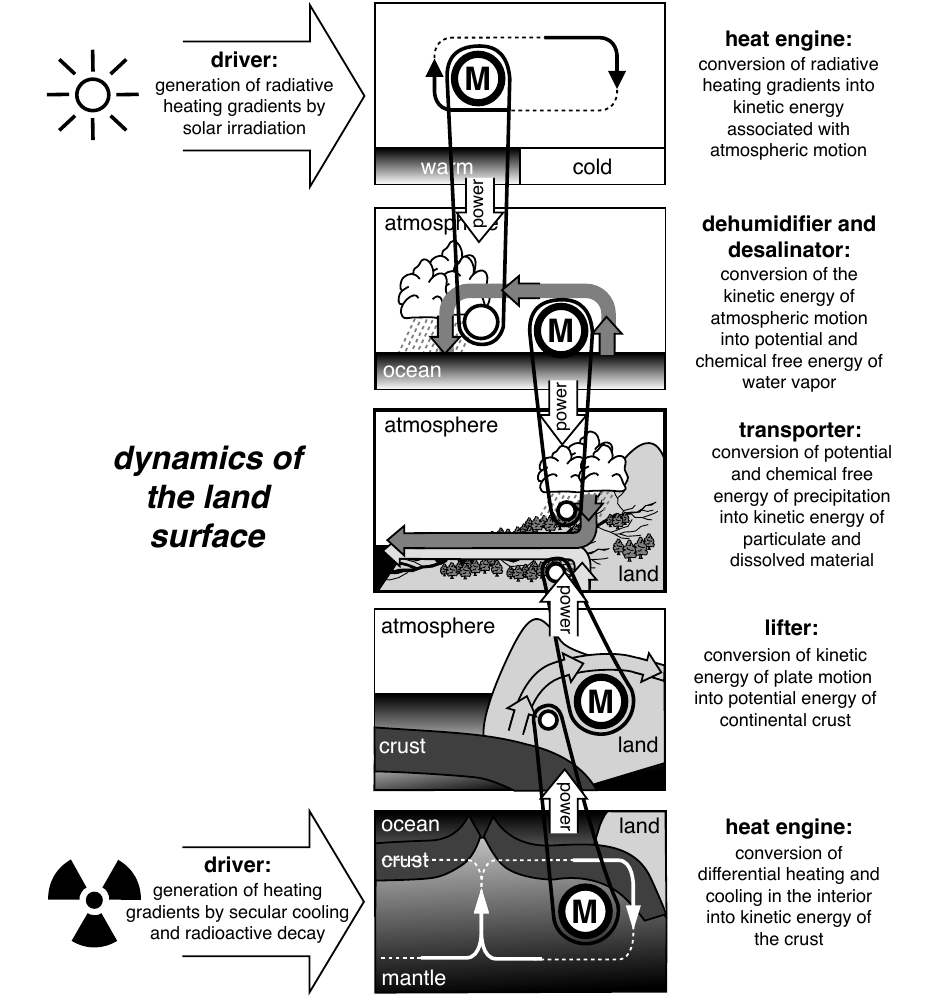
Fig. 2. Schematic diagram illustrating the paths of how free energy is generated and transferred from heating gradients to drive the shaping of drainage systems by geologic and hydrospheric processes. The upper part of the diagram shows how radiative heating gradients fuel the atmospheric heat engine, which in turn acts to dehumidify and desalinate ocean water, which then provides the precipitation input to drive sediment transport. The lower part of the diagram shows how heating gradients in the interior result in plate tectonics and continental uplift, which in turn maintains the topographic gradients for continental river flow. The symbol “ M ” represents an engine that converts the displayed gradient into power. After Kleidon et al.